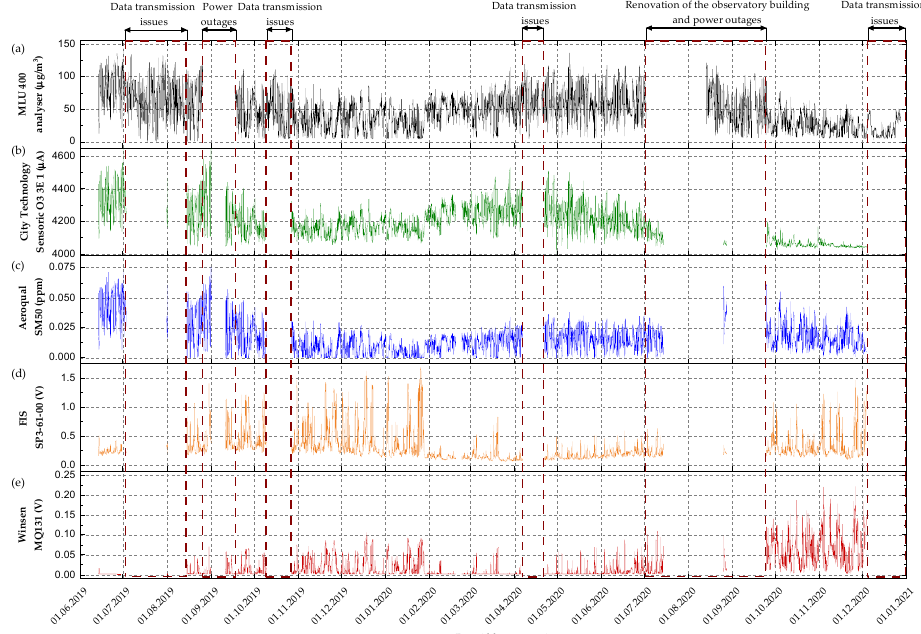
Figure 1. Results of the O 3 measurement campaign: ( a ) MLU 400 reference analyser; ( b ) SensoriC O3 3E 1 (City Technology); ( c ) SM50 OZU (Aeroqual); ( d ) SP3-61-00 (FIS); and ( e ) MQ131 (Winsen). The 1 h averaged data for selected sensors were plotted for clarity. Please note the different scales and units on the y -axes.